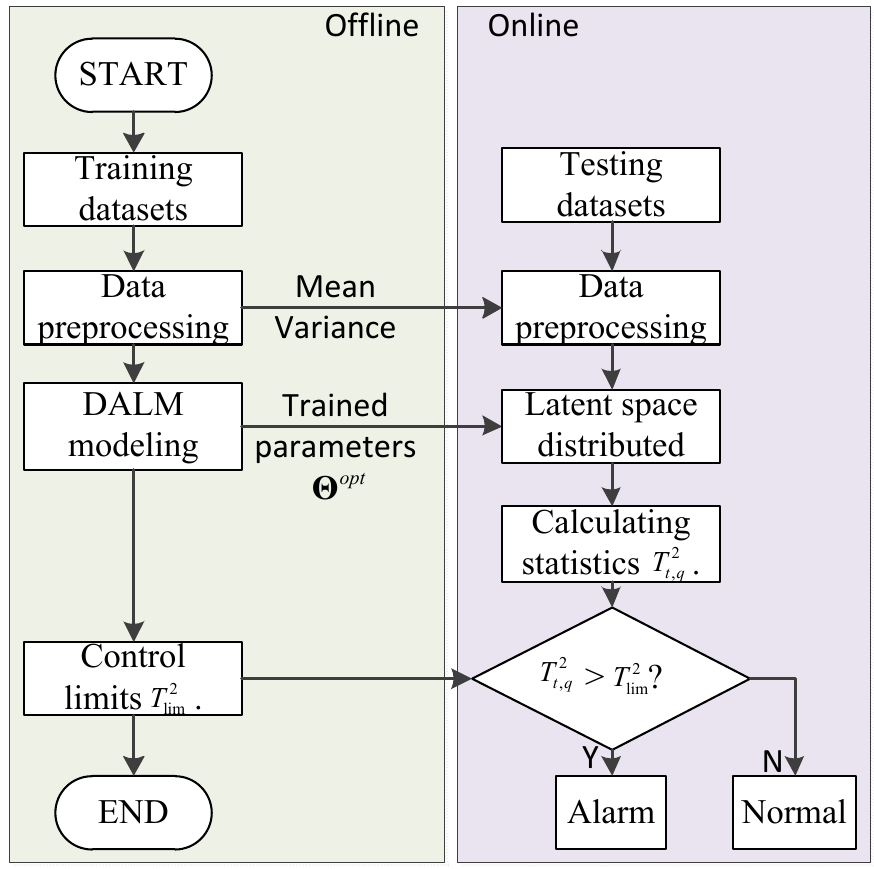
Figure 2. Flowchart based on DALM process monitor.